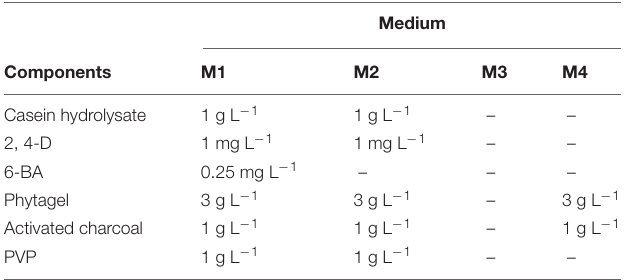
TABLE 1 | Tissue culture media used for embryogenic culture induction (M1), maintenance (M2), colchicine treatment (M3), and somatic embryo initiation (M4) of Magnolia officinalis